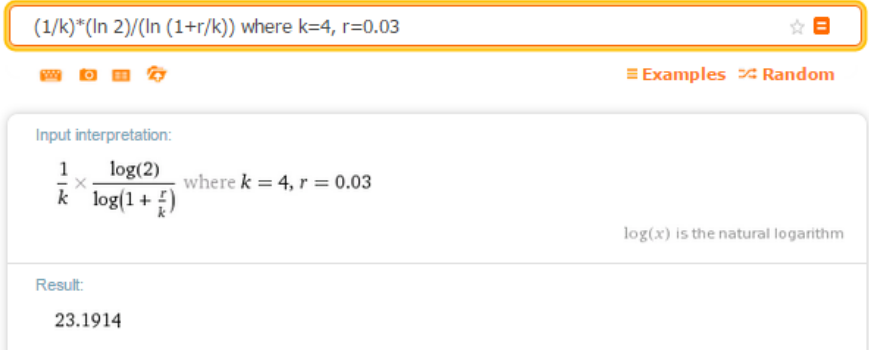
Fig. 2. Calculation of number of years by using derived formula